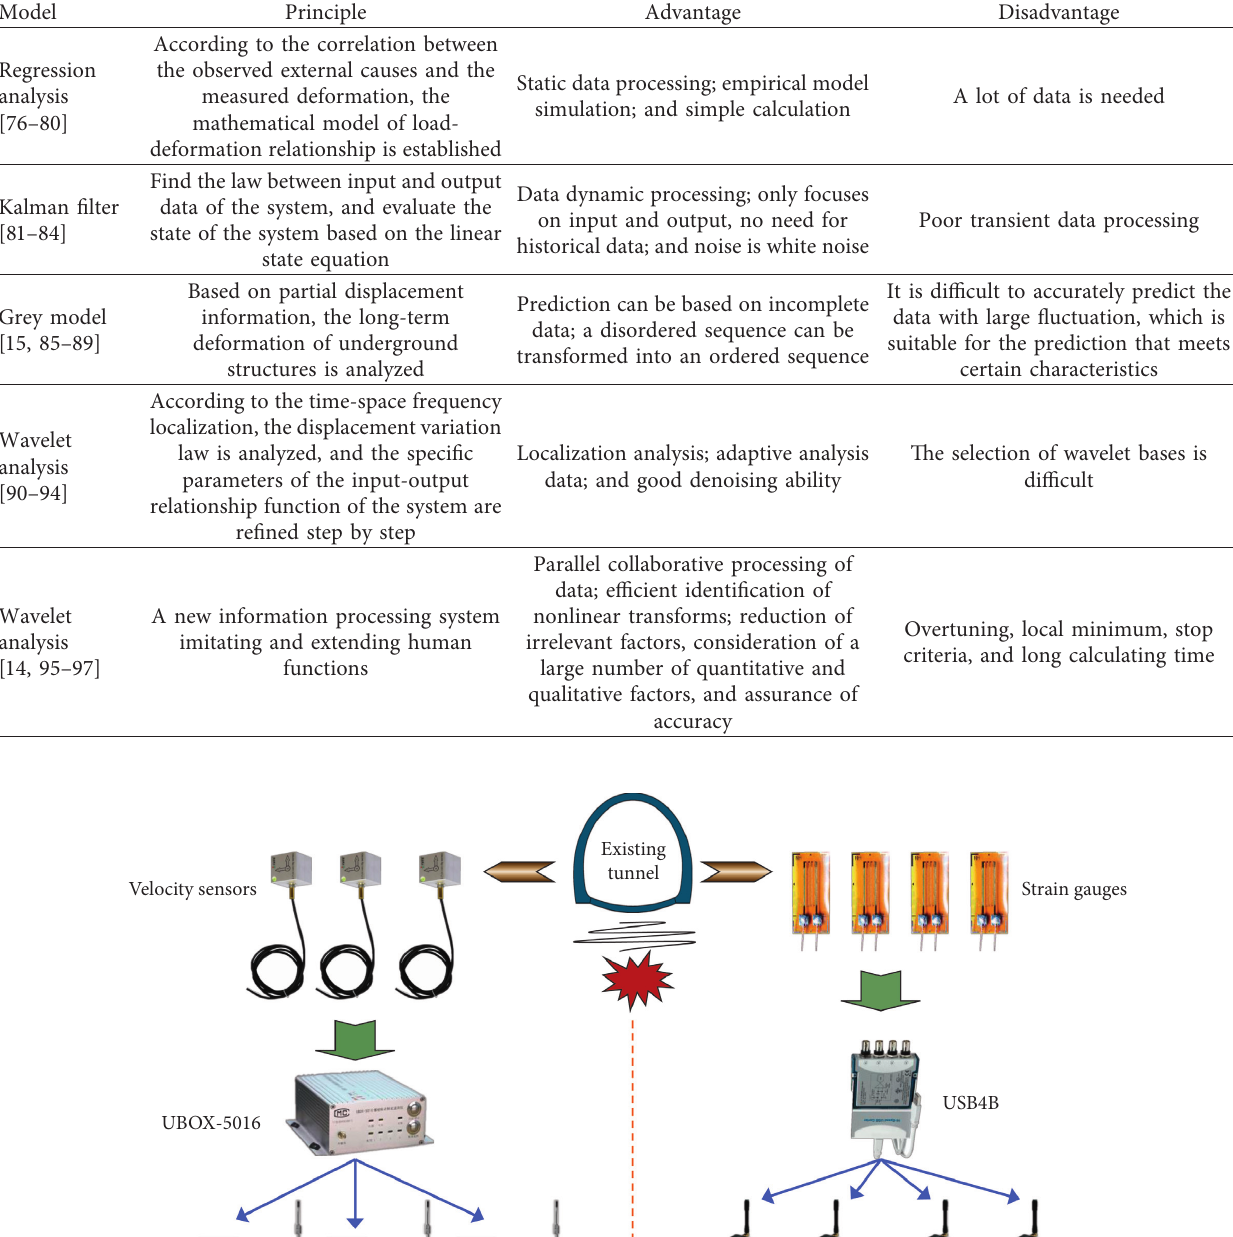
Table 4: Deformation data processing and prediction method